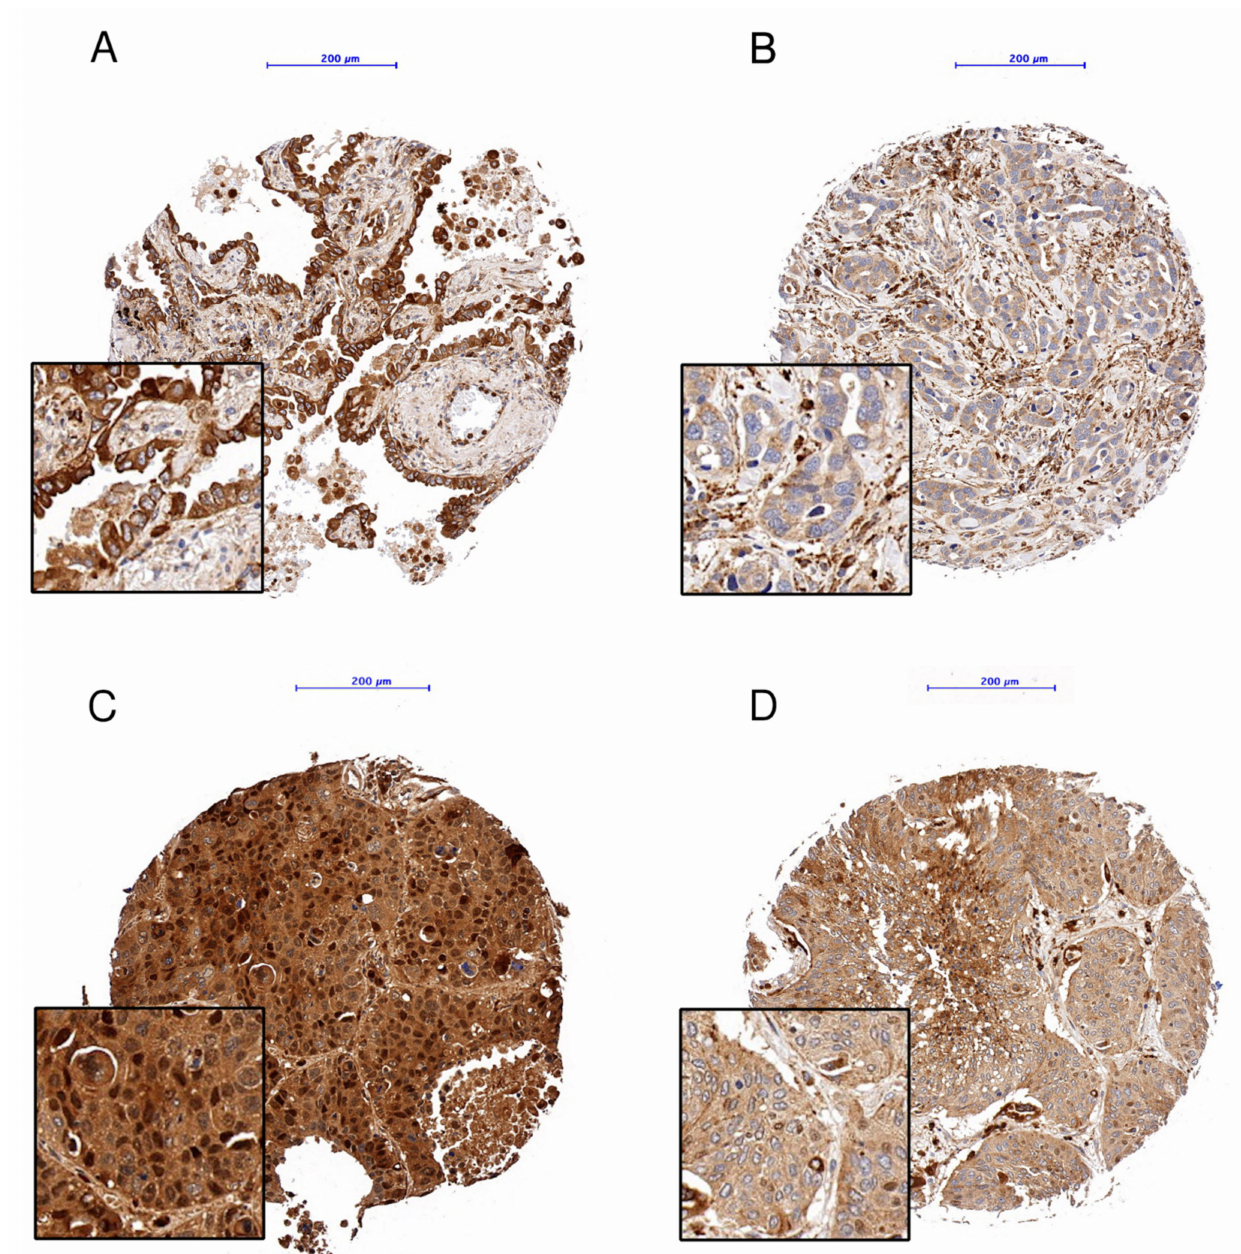
Figure 2. LAMP2A, examples of immunohistochemical staining, ( A ): Adenocarcinoma, IRS 3 × 4 = 12; ( B ) Adenocarcinoma, IRS 1 × 4 = 4; ( C ): Squamous cell carcinoma, IRS 3 × 4 = 12; ( D ): Squamous cell carcinoma, IRS 2 × 4 = 8; Objective magnification: 10 × , Scale bar: 200 µ